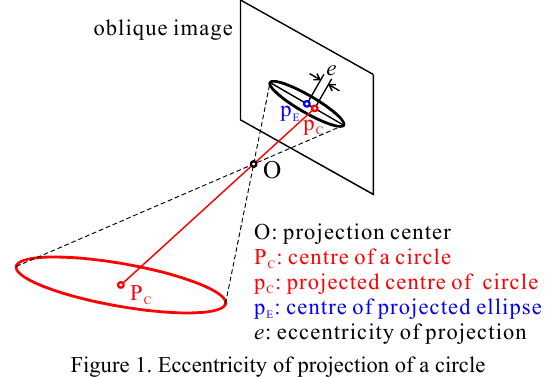
Figure 1. Eccentricity of projection of a circle Regarding the eccentricity of a circle, Matsuoka et al. (2009) showed a formula calculating an eccentricity of a circle using the size and the location of a circle, and the focal length, the position and the attitude of a camera only when the circle lies on the horizontal plane. Moreover they presented merely the finally derived equation, although it would be convenient to show a process to derive the